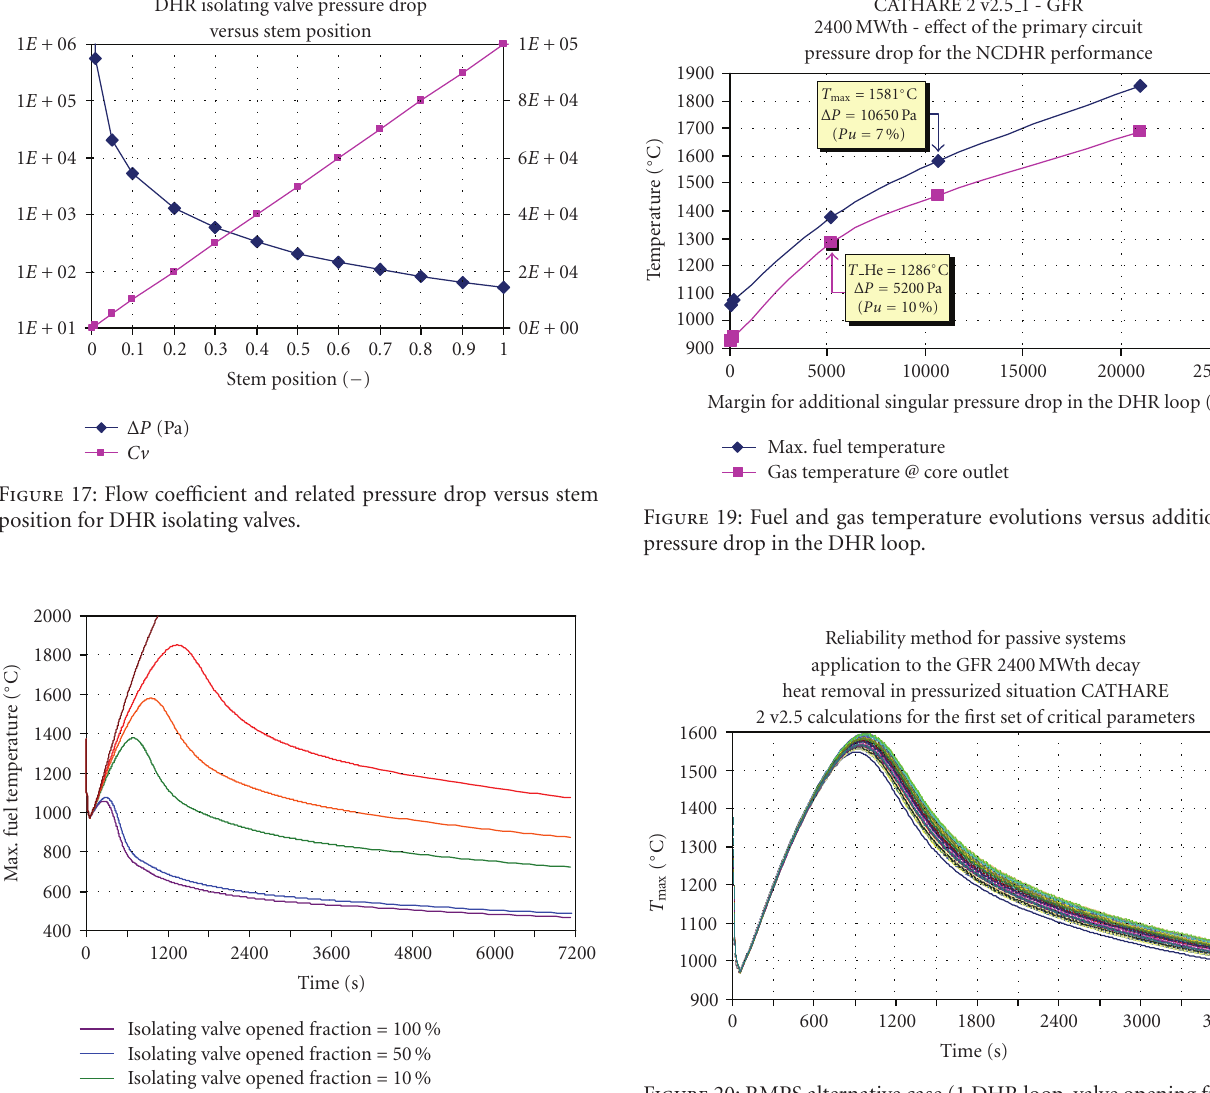
Figure 20: RMPS alternative case (1 DHR loop, valve opening frac- tion = 7%). Table 5: Results for the RMPS alternative